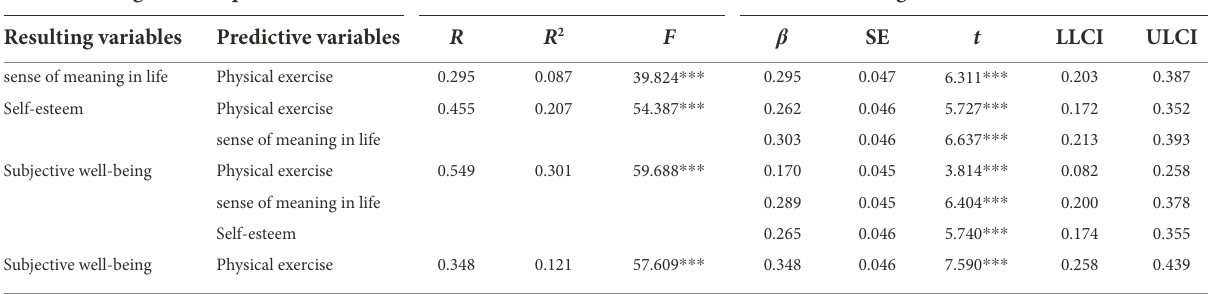
TABLE 3 Chain mediated model regression analysis of physical exercise, sense of meaning in life and self-esteem on subjective well-being of older people. Regression equation